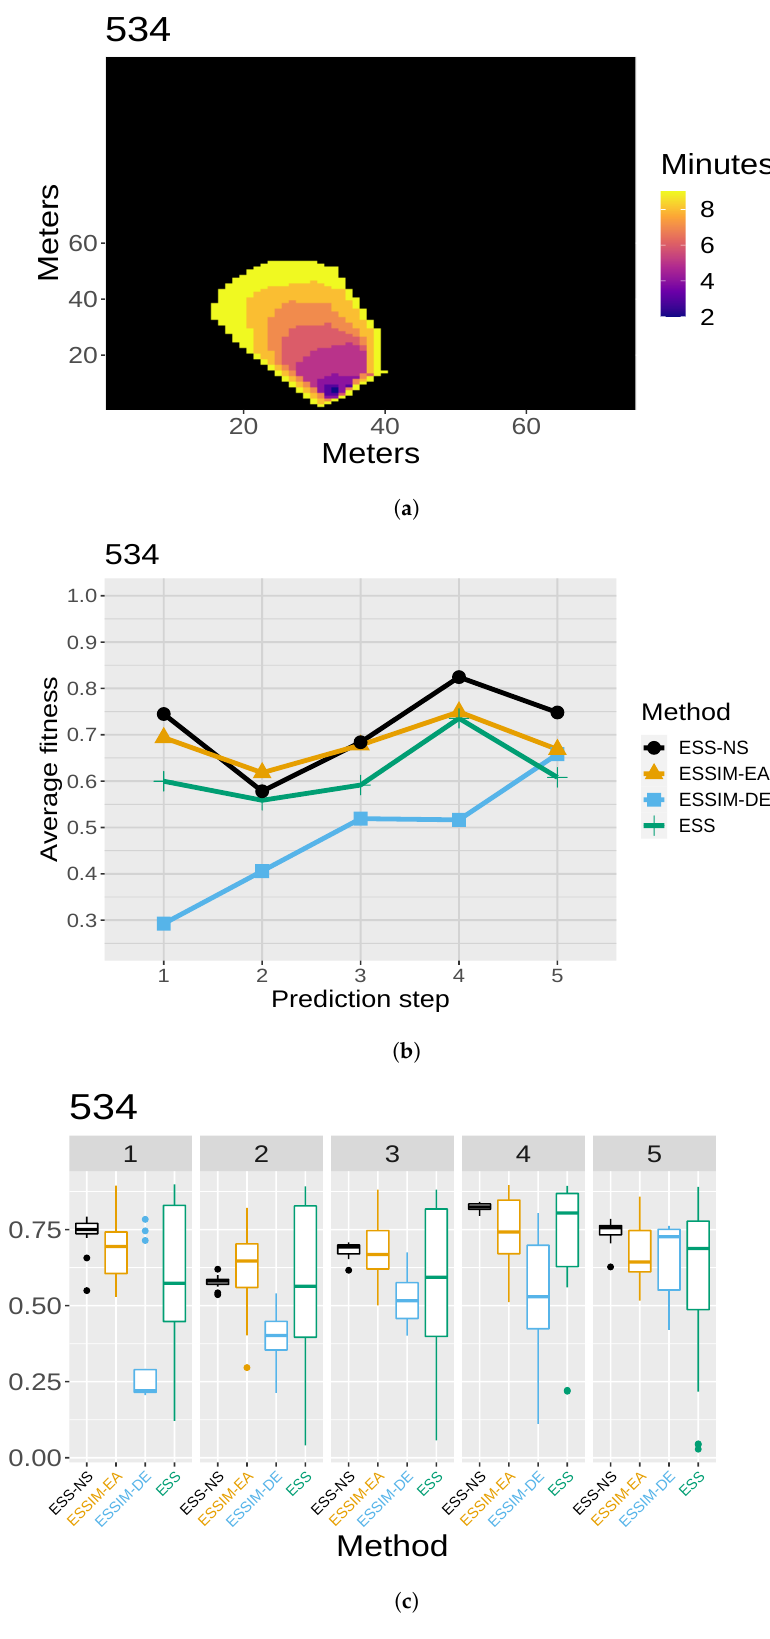
Figure 11. Case 534: ( a ) map of the real fire spread; ( b ) fitness averages; and ( c ) fitness